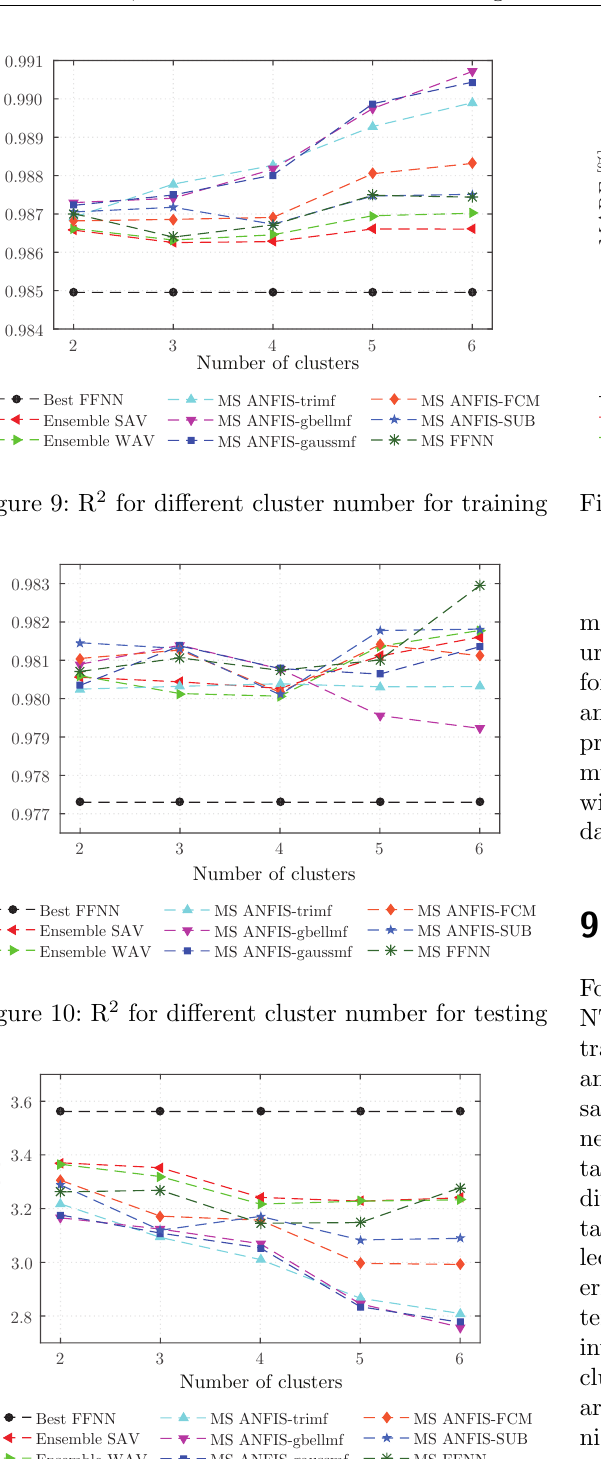
Figure 11: MAPE for different cluster number for training